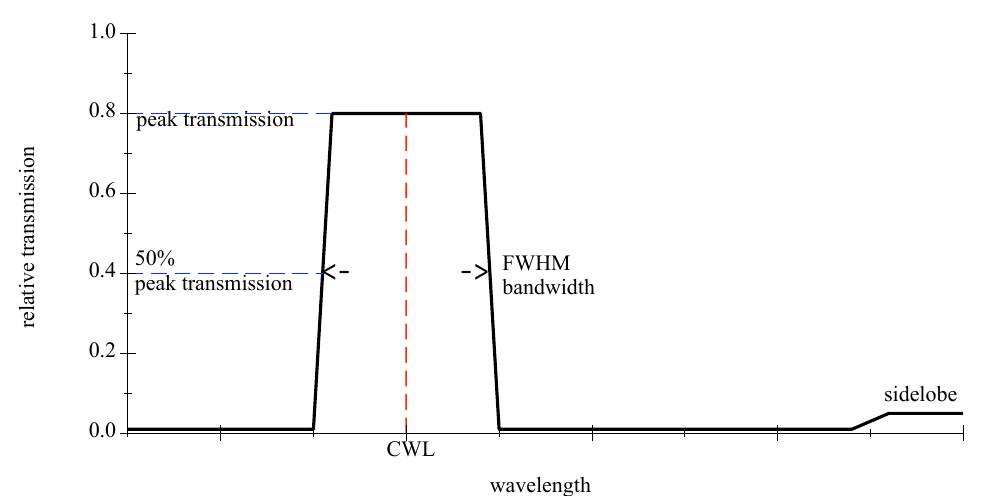
Figure 8. Graphic is showing an idealized bandpass